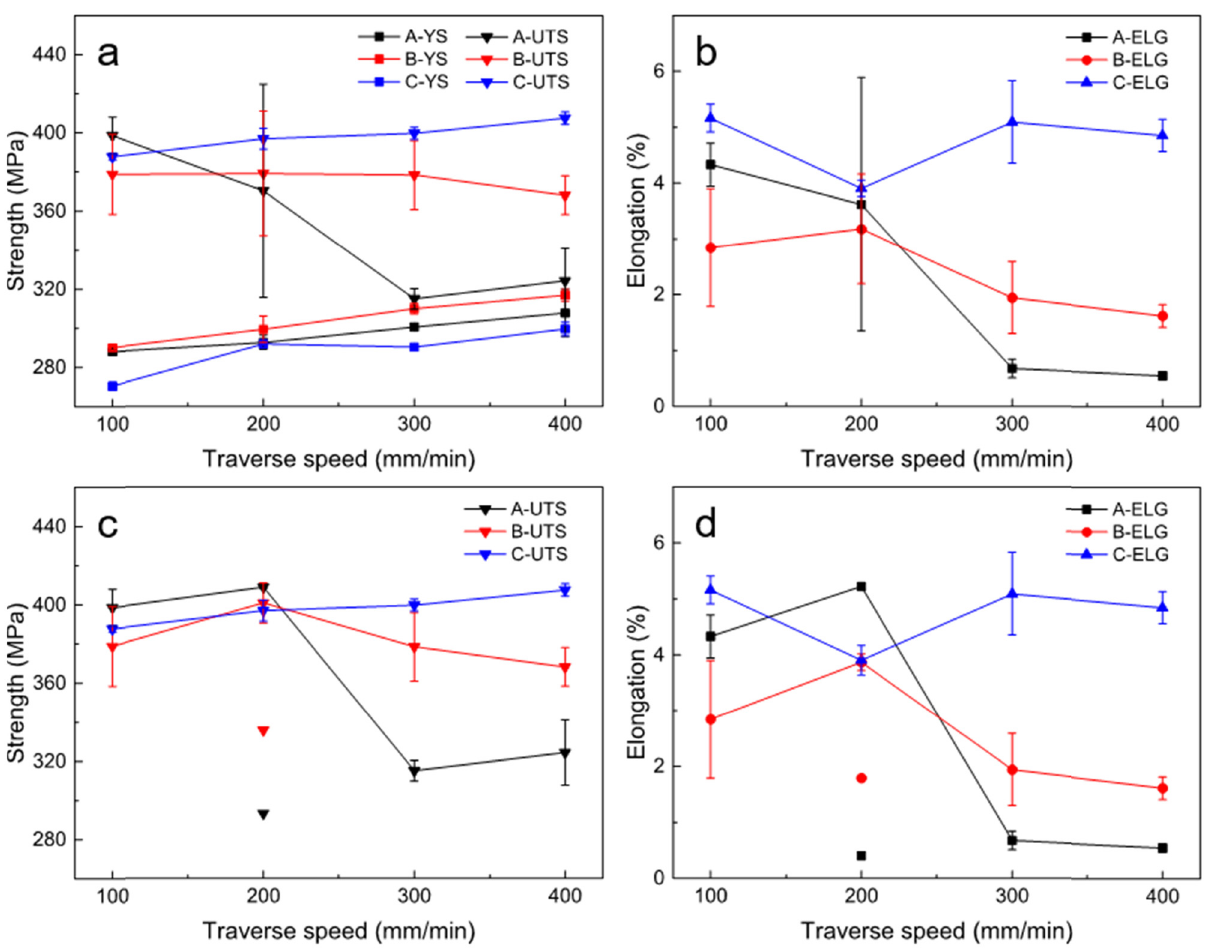
Figure 7: Properties change of A, B, and C series as the increase of TS: ( a ) YS and UTS, and ( b ) elongation; ( c ) UTS and ( d ) elongation ( specimens with fracture mode M3 in A2 and B2 are separated )